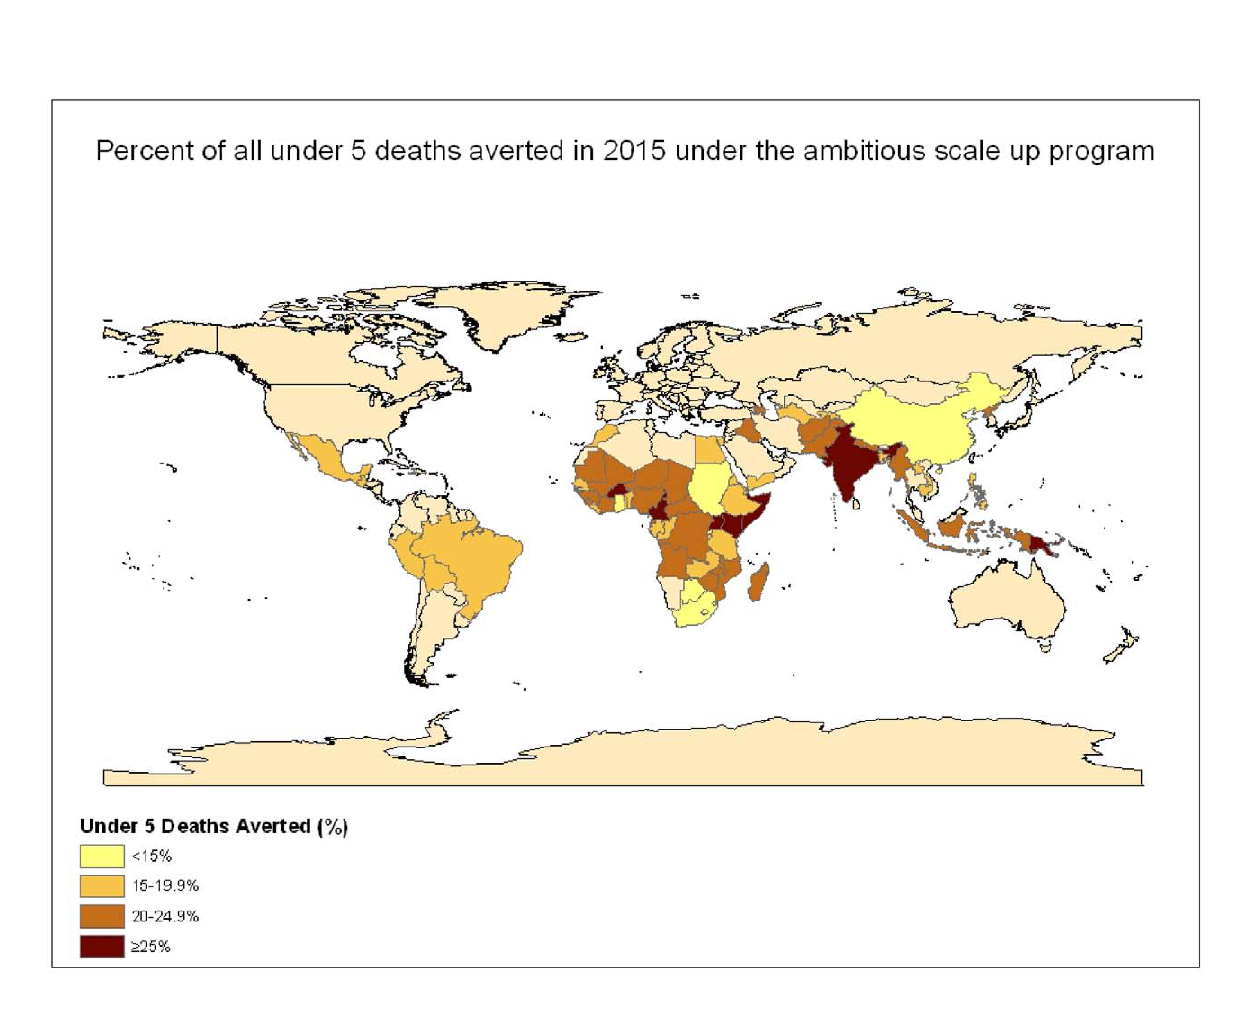
Figure 2. Number of child deaths averted in 2015 under the universal scale-up program for the 68 countries included in the analysis. doi:10.1371/journal.pmed.1000428.g002 PLoS Medicine |